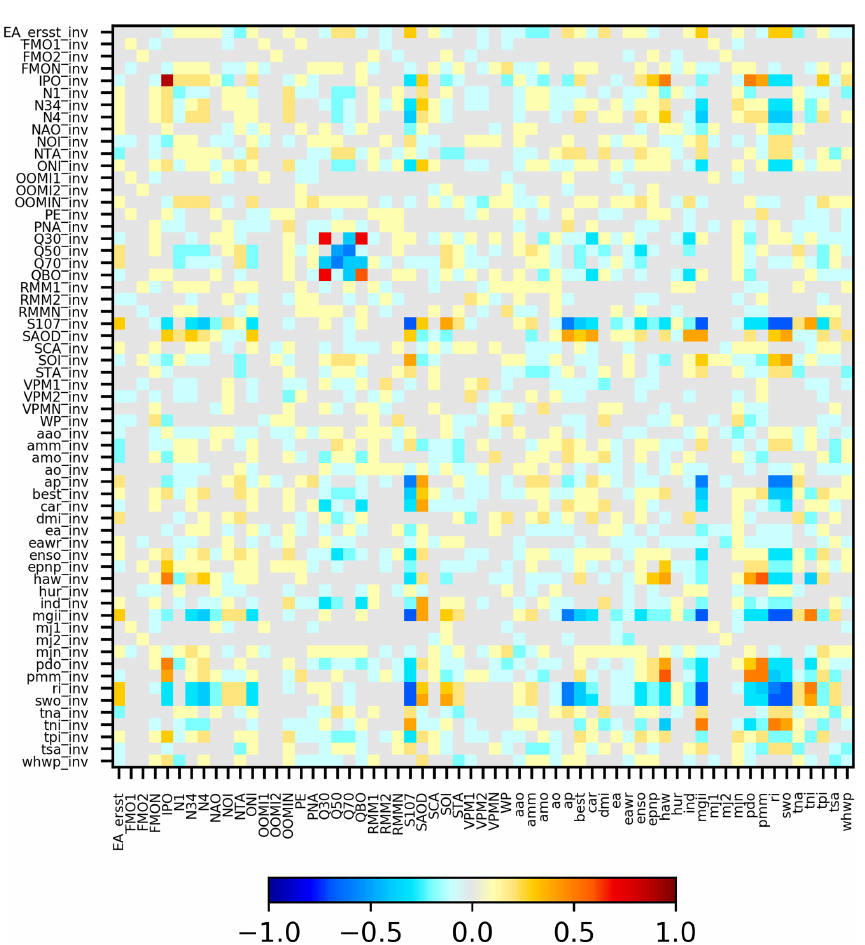
Figure A2. Correlation coefficients between the temporally reversed and original indices. For several combinations enhanced coincidental correlations are